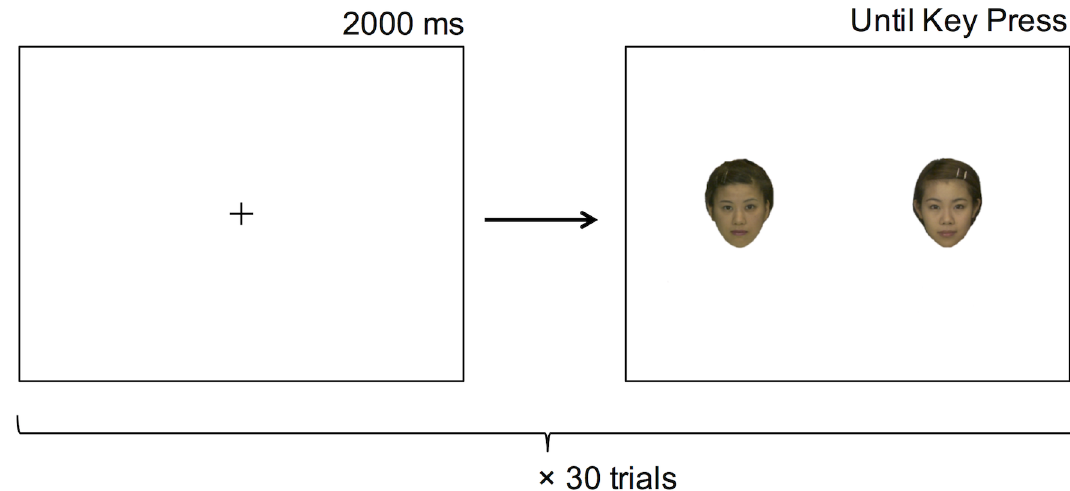
Fig 3. Example of a trial in Experiment 1. After a fixation point was presented in the center of the screen (2000 ms), a pair of photos was presented on the monitor. Once participants made a decisionby pressing a key, the photos were replaced by the fixation point, before starting the next trial. This procedurewas repeatedfor 30 trials in each task block (preferenceand